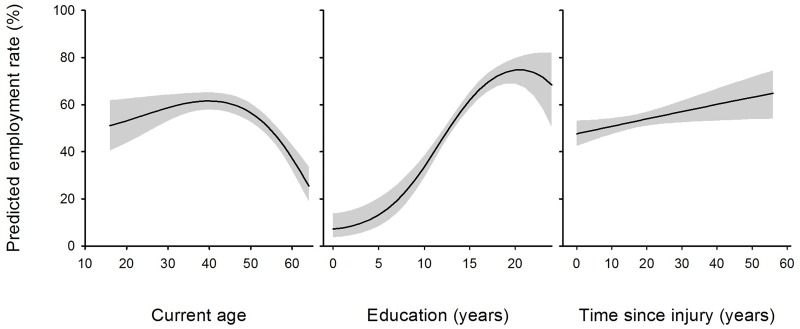
Adjusted marginal predictions of employment rates for continuous predictor variables in Table 2.Predictions are at means for all other variables in the multivariable model with grey areas indicating the 95% confidence interval.